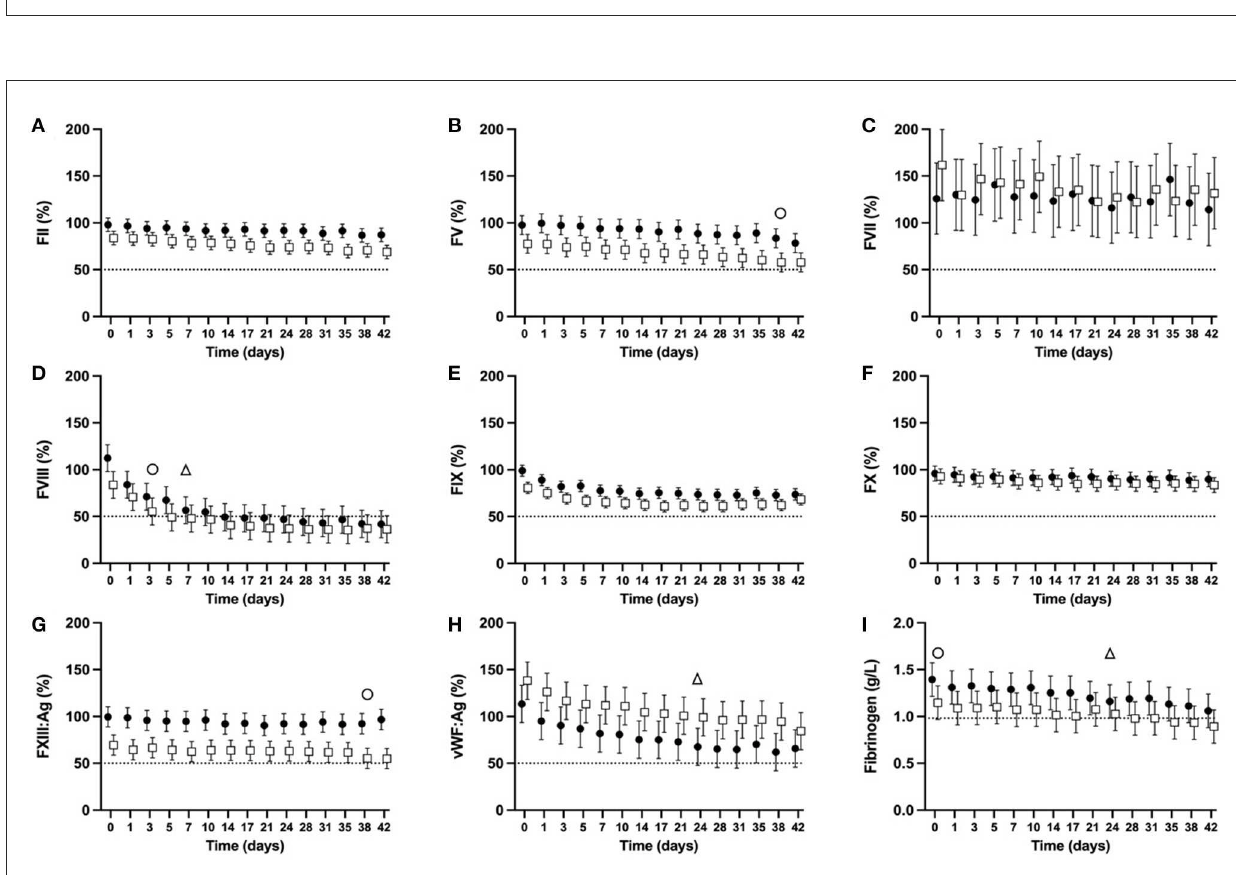
FIGURE5 Serial estimated marginal means and 95% confidence intervals for percentage coagulation factor activities [FII (A) , FV (B) , FVII (C) , FVIII (D) , FIX (E) , FX (F) , FXIII:Ag (G) , vWF:Ag (H) ], and fibrinogen concentration (I) of plasma derived from whole blood from non-greyhound ( • ) and greyhound ( (cid:3) ) dogs cold-stored for 42 days (CSWB). Plasma was separated from CSWB and frozen at − 80 ◦ C before thawing and batch analysis of coagulation factor activity. The open triangle ( 1 ) and open circle (o) denotes when the estimated marginal mean falls below 50% of baseline for non-greyhound and greyhound CSWB, respectively. The dotted line represents 50% coagulation activity (A–H) , and a fibrinogen concentration of 0.982 g/L (I)